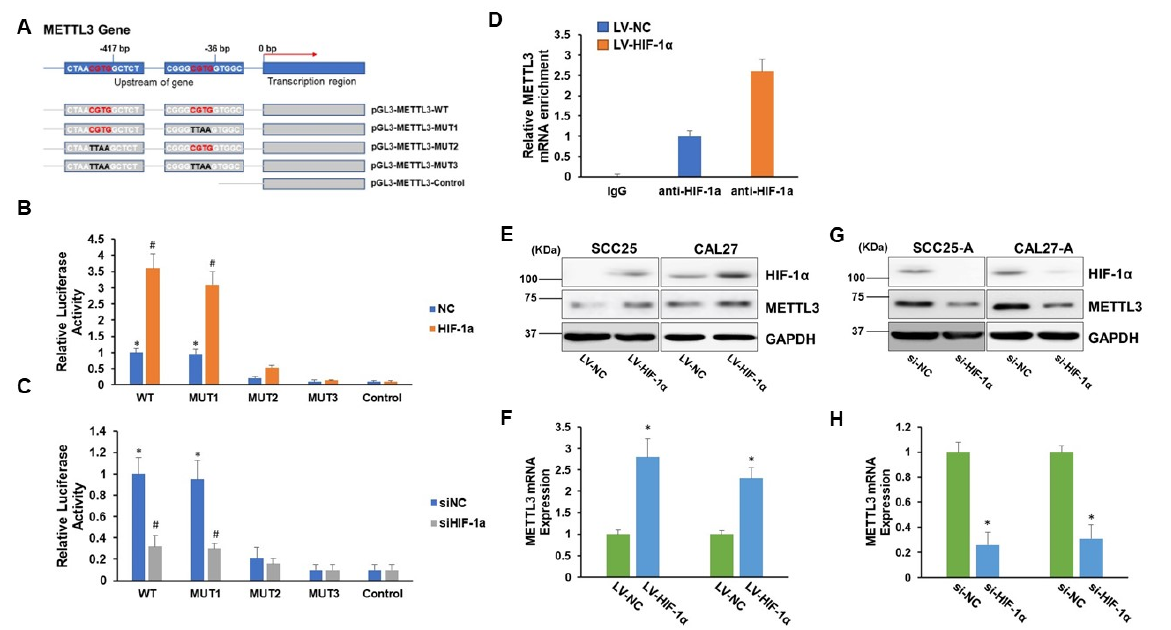
Figure 2. METTL3 is regulated by HIF-1 α . ( A ) A schema of a variety of pGL3-METTL3 plasmids (WT, MUT1, MUT2, MUT3, or control). ( B , C ) 293T cells were transduced with lentiviral particles carrying HIF-1 α or control (NC) ( B ) or transfected with siRNA targeting HIF-1 α (siHIF-1 α ) or con- trol (siNC) ( C ). Then, the cells were cotransfected with one of the pGL3-METTL3 plasmids (WT, MUT1, MUT2, MUT3, or control) along with pRT-TK vectors, which served as an indicator for trans- fection efficiency. The luciferase levels were de-termined 24 h after transfection. * p < 0.05 compared to the control group. # p < 0.05 HIF-1 α group compared to the NC group or siHIF-1 α group com-